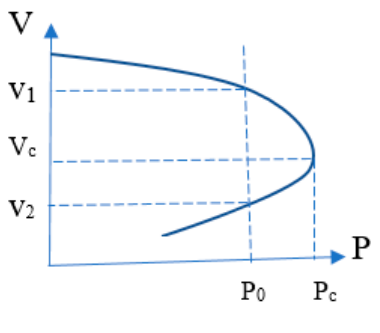
Figure 5. P-V curve.